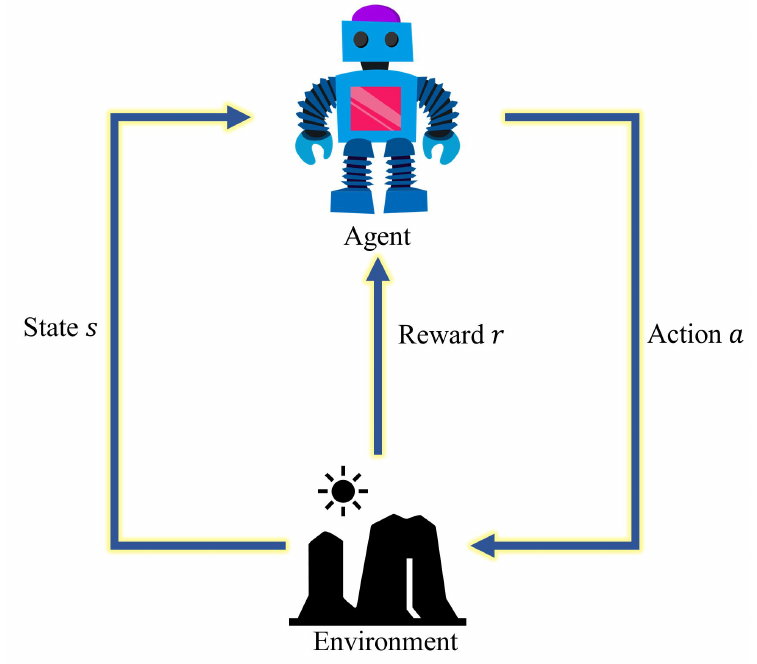
Figure 1. Reinforcement learning